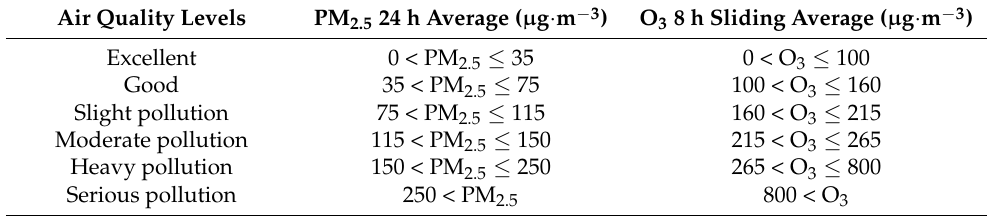
Table 1. Air quality levels corresponding to PM 2.5 and O 3 concentration